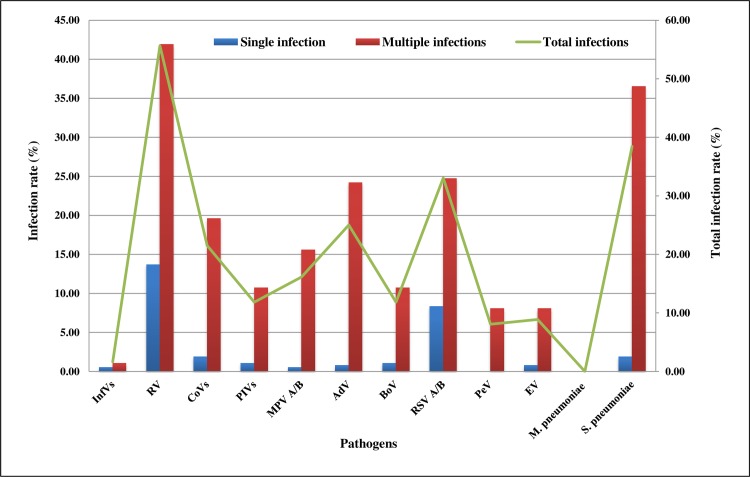
Pathogens etiology within the tested samples.At the left y-axis, the rates of pathogen ARTIs are given. The rates of single infection are shown in blue, and the rates of multiple infections in red. The total infection rates are presented by the green line (right y-axis). InfVs, CoVs, and PIVs types are combined in groups.